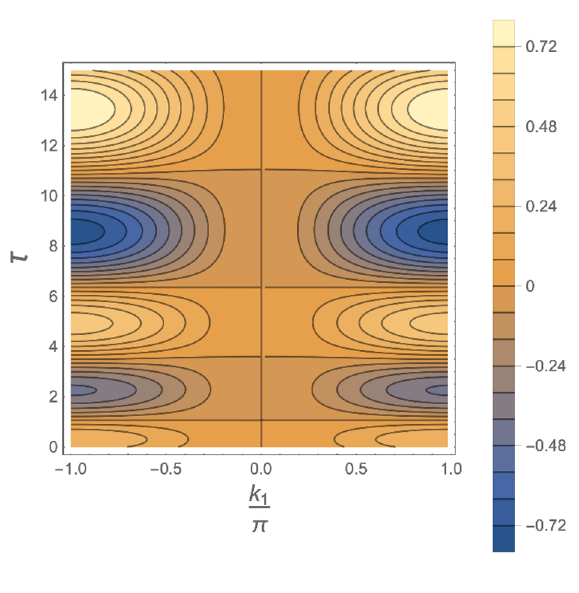
Figure 9 . A contour plot of (cid:22) p k ( (cid:28) ) in the plane of (cid:28) and k = ( k 1 ; 0 ;